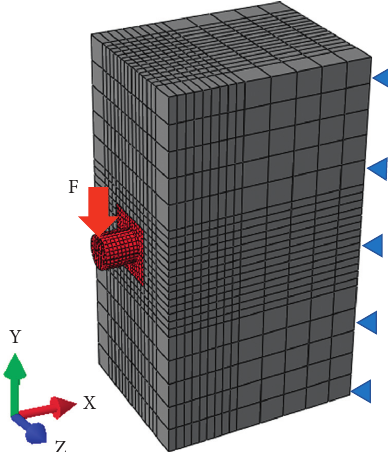
Figure 14: Finite element model of steel shear keyed joint in construction state.